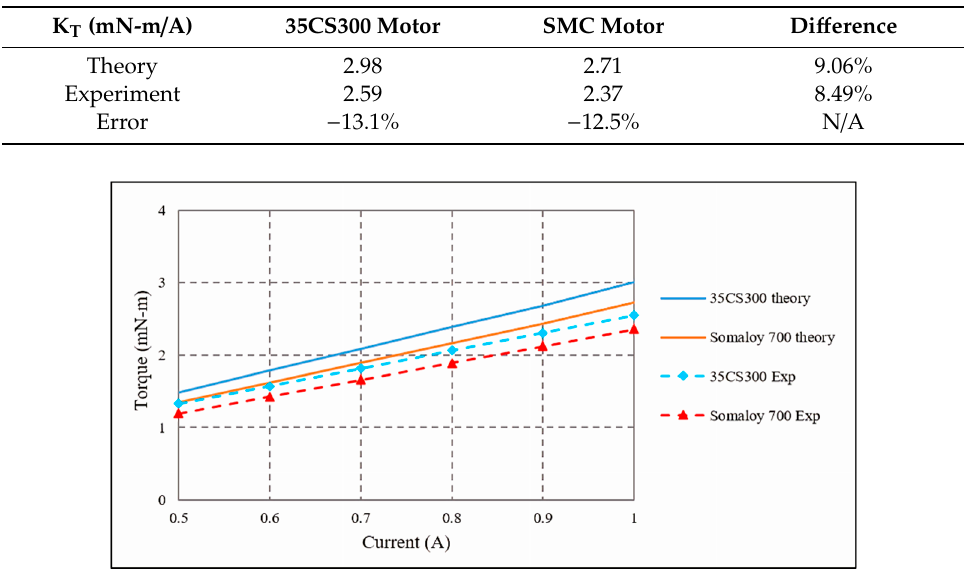
Figure 13. Torque-current curves of 35CS300 and Somaloy 700 1P motors.